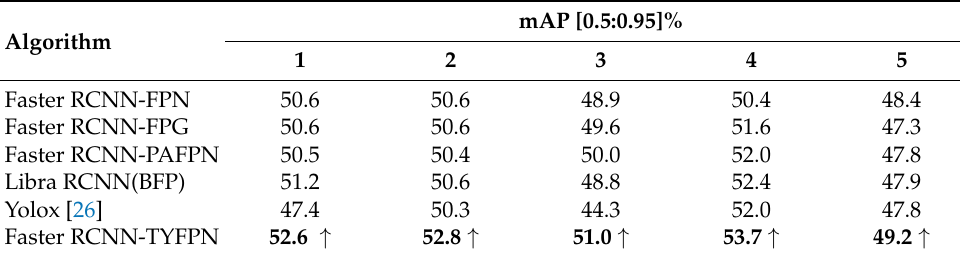
Table 2. mAP [0.5:0.95] evaluation metrics for different algorithms.